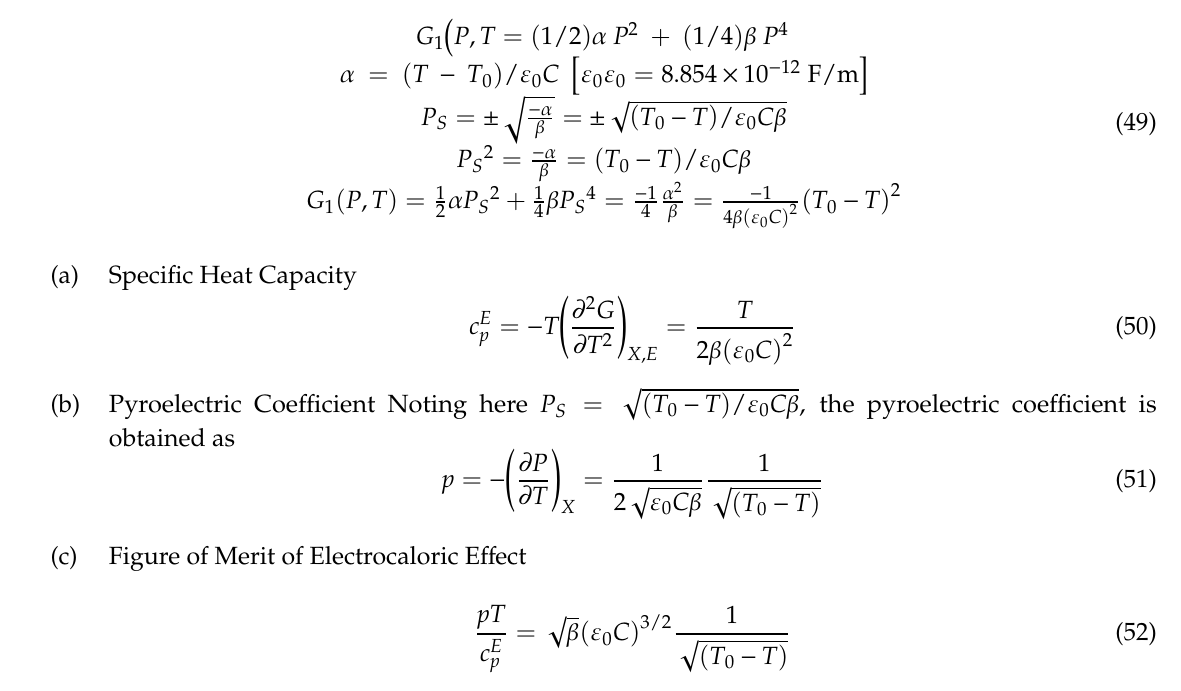
Figure of Merit of Electrocaloric E ff